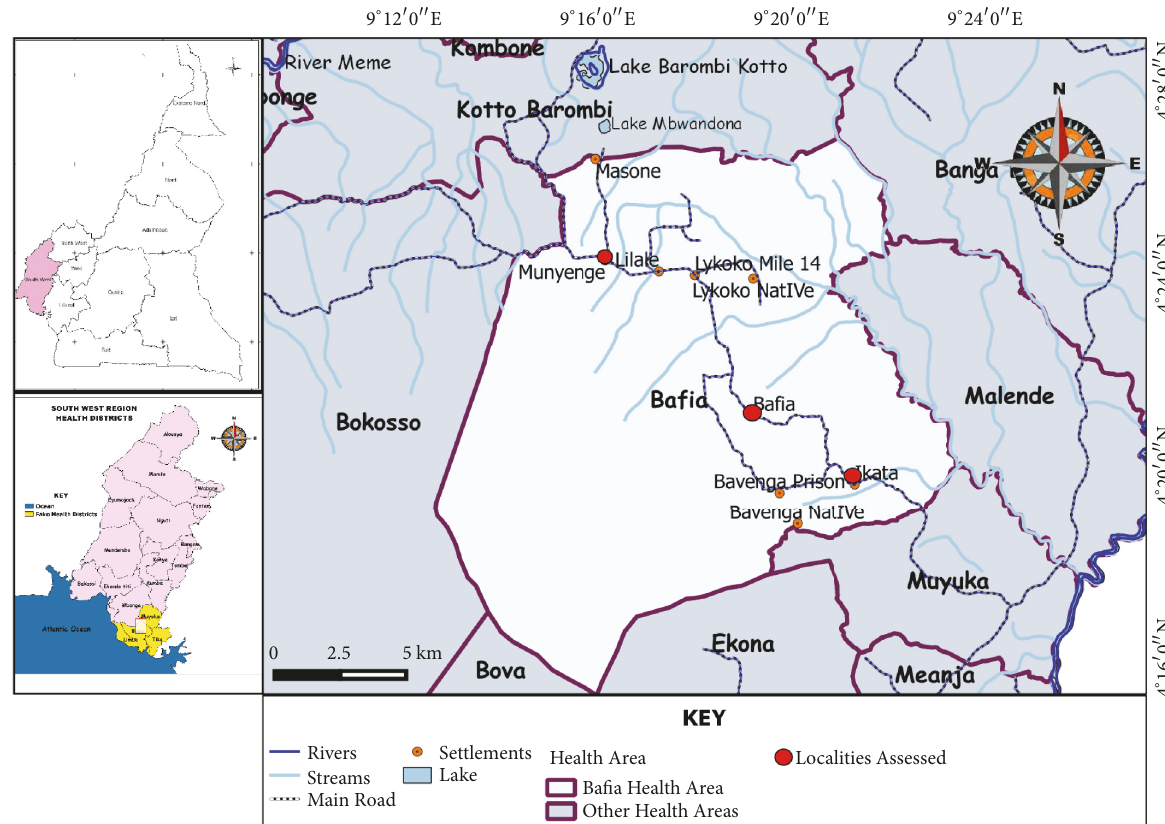
Figure 1: Map showing Bafia Health Area in the Mount Cameroon